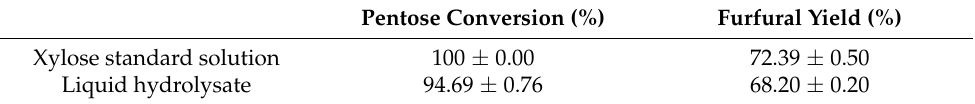
Table 5. Pentose conversion and furfural yield from xylose standard and dilute acid